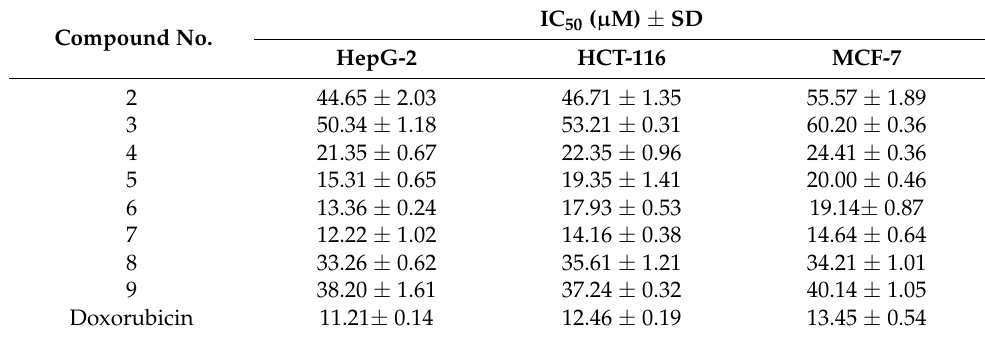
Table 3. Preliminary in vitro cytotoxicity values of the target derivatives 2–9 and doxorubicin. Compound